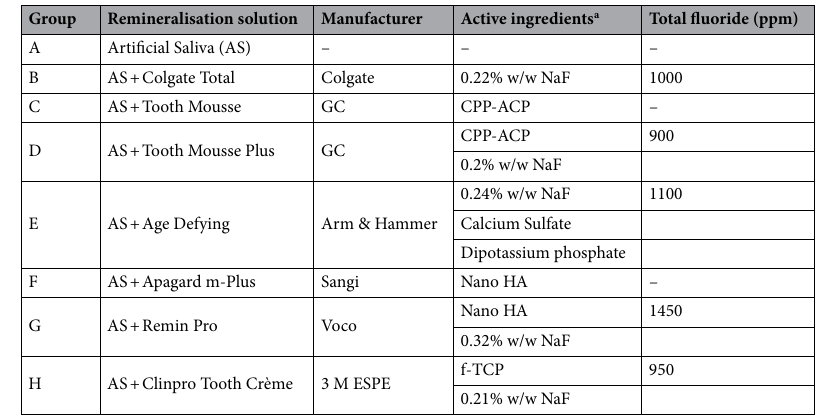
Table 1. Remineralisation treatments: active ingredients, fluoride concentration and dilution factor in artificial saliva (AS). CPP-ACP casein phosphopeptide-amorphous calcium phosphate, Nano-HA nanohydroxyapatite, f-TCP functional tricalcium phosphate.